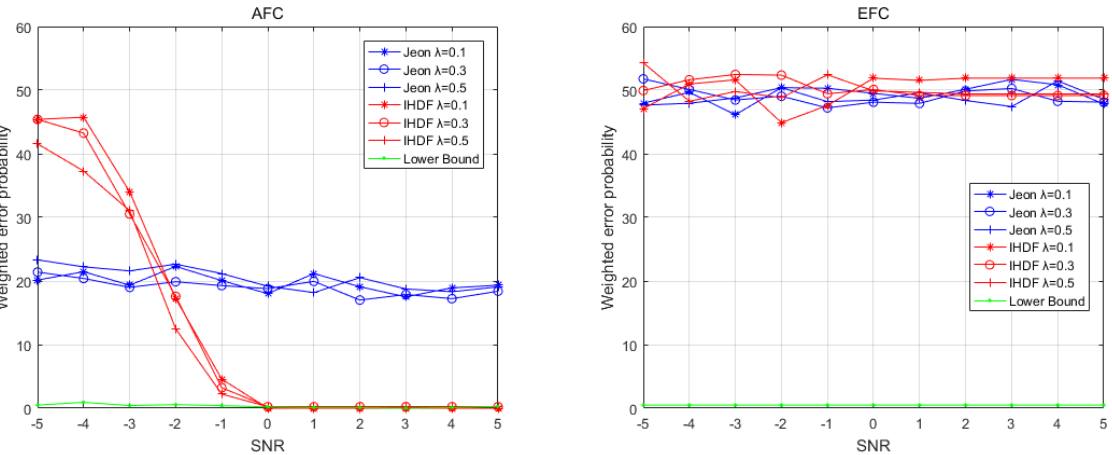
Figure 3. The weighted error probabilities at the AFC and EFC as a function of SNR in ideal channel conditions.